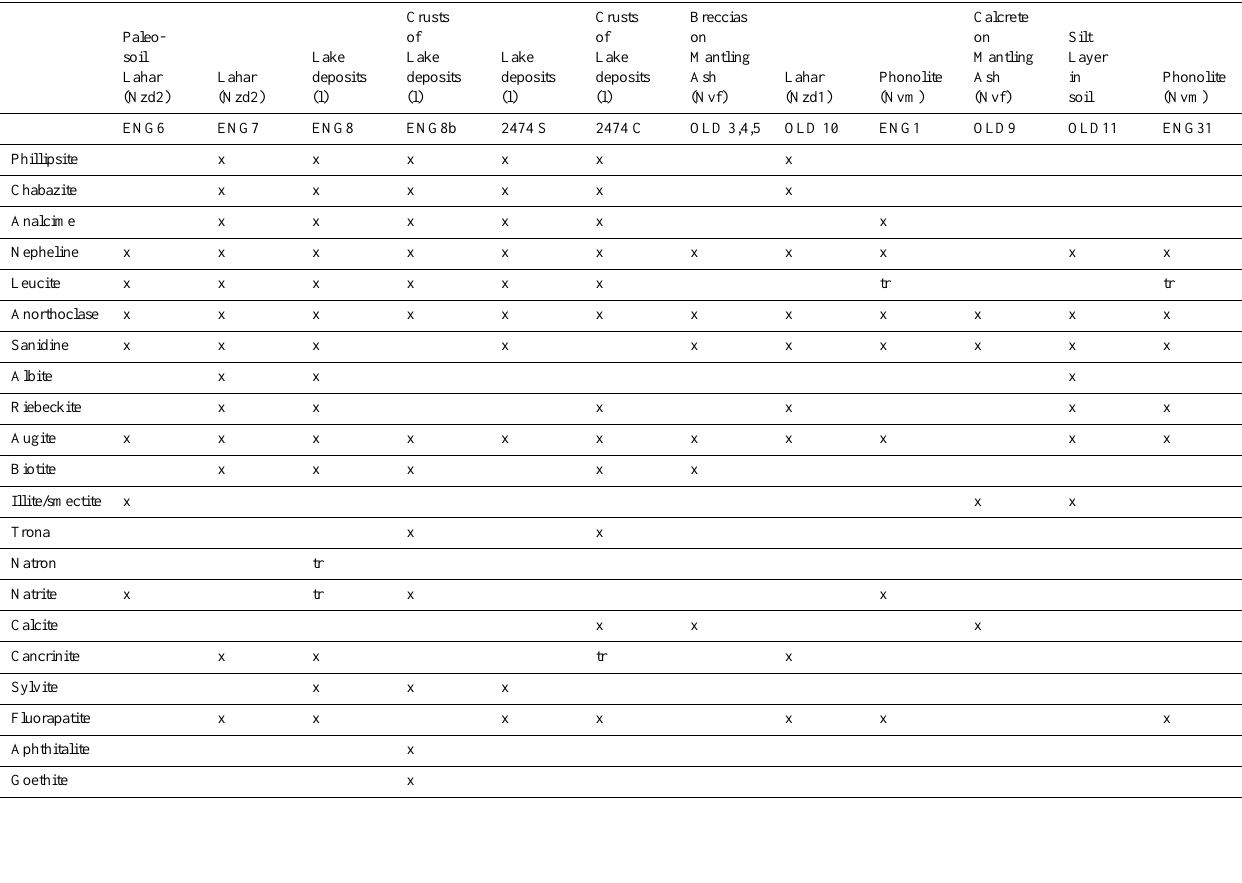
Table 2. Mineral composition of sediments and rocks samples. Crusts Crusts Breccias Calcrete Paleo- of of on on Silt soil Lake Lake Lake Lake Mantling Mantling Layer Lahar Lahar deposits deposits deposits deposits Lahar